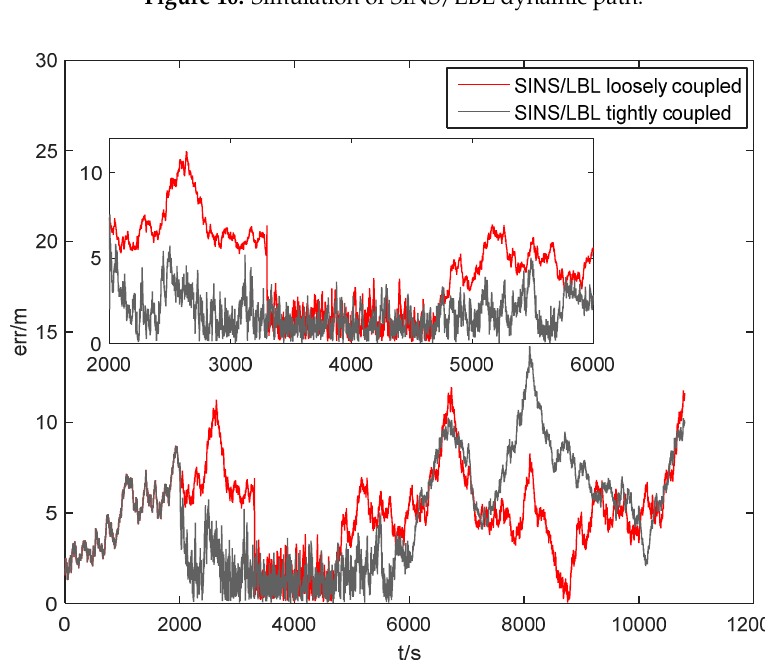
Figure 11. Position error comparison of SINS/LBL dynamics simulations.